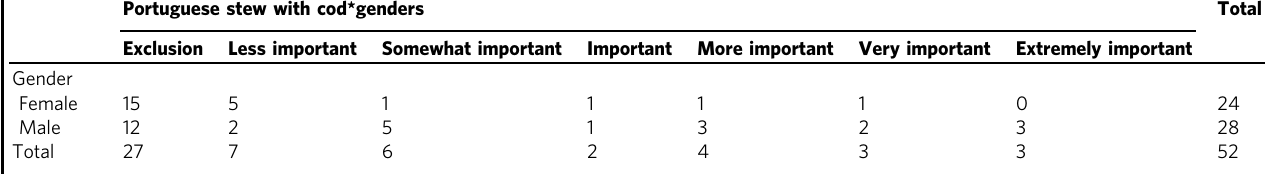
Table 15 Contingency table with the valuation of the identity symbol ‘ Portuguese stew with cod ’ and students ’ gender. Portuguese stew with